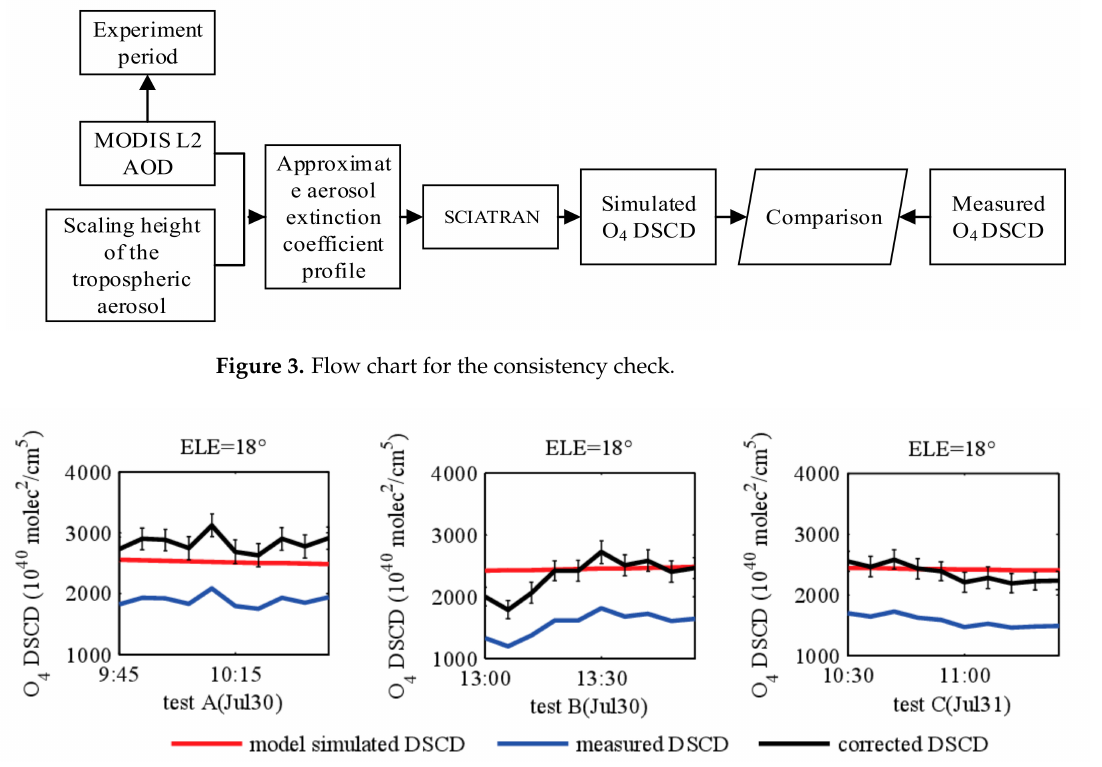
Figure 4. Consistency check of A, B, C test: the model simulated DSCDs, measured DSCDs, and corrected DSCDs at 18 ◦ ELE. The red lines refer to the O 4 DSCDs simulated by the SCIATRAN model, the blue lines represent the O 4 DSCDs measured by the MAX-DOAS instrument, and the black lines are the measured O 4 DSCDs multiplied by the correction